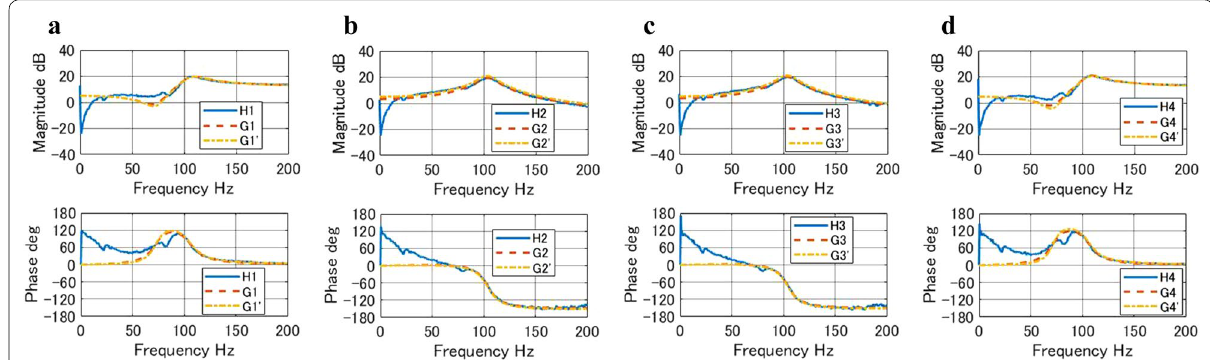
Fig. 7 Comparison of measured frequency responses H i and transfer functions G i and G ′ i . a H 1 , G 1 and G ′ 1 , b H 2 , G 2 and G ′ 2 , c H 3 , G 3 and G ′ 3 , d H 4 , G 4 and G ′ 4